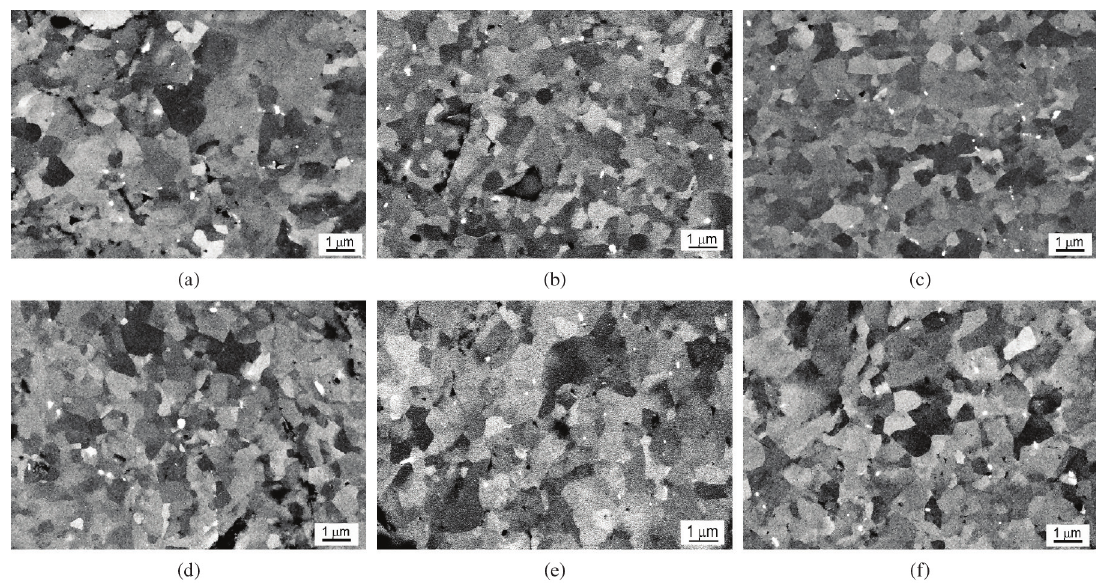
Figure 4. SEM images obtained by crystallographic contrast using back-scattered electron, showing grain sizes in the aluminium matrix of the composite. (a) extruded condition; (b) 2 ECAP passes by route A at room temperature; (c) 3 ECAP passes by route A at room temperature; (d) 4 ECAP passes by route B at room temperature; (e) 4 ECAP passes by route A at 150°C; (f) 4 ECAP passes by route C B at C Table 1. FeAlCr particle size, grain size, experimental yield stress ( σ ), tensile stress ( σ ) and tensile ductility for the composite in the y max as extruded condition and after ECAP. Material Condition